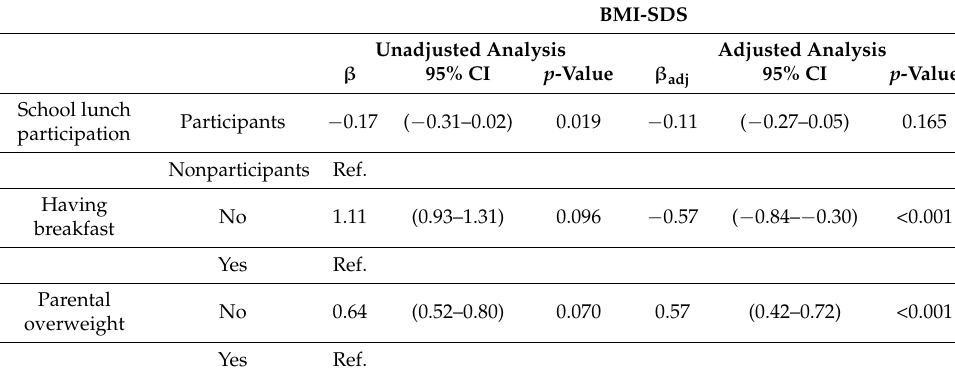
Table 6. Associations between BMI ( n = 808) and school lunch participation. Effects are given as β (95% CI).